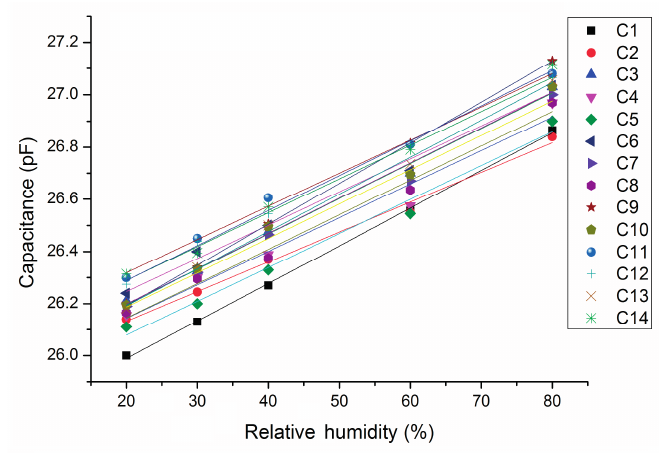
Figure 8. Measured capacitance versus relative humidity at 37